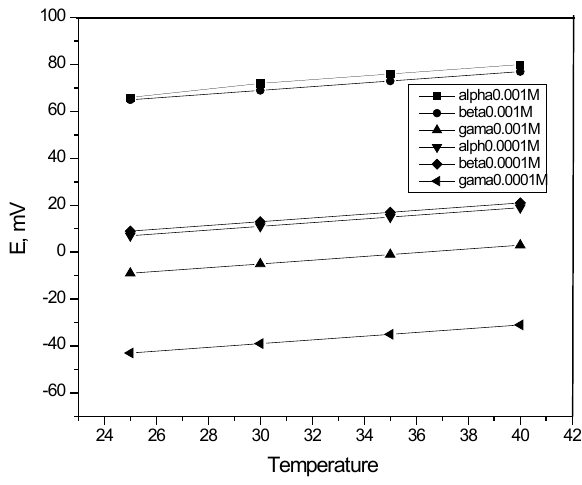
Figure 4 : Effect of temperature on the developed sensors.